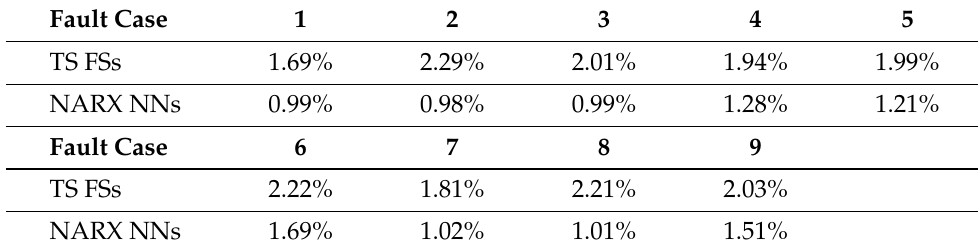
Table 6. RMSE % index for the HIL